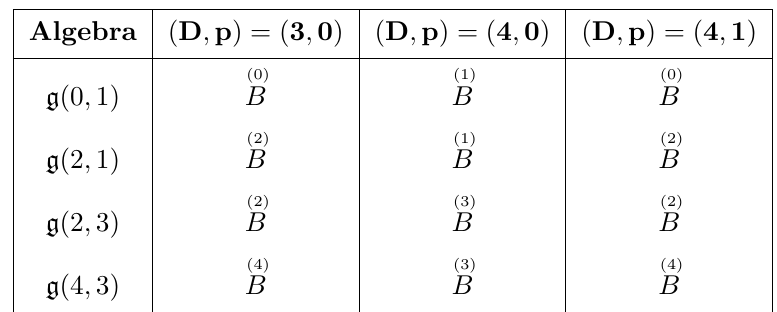
Table 1 . In the table we list, for di(cid:11)erent values of ( D; p ; N is invariant under the algebra g ( N 0 ; N 1 ) appearing in the (cid:12)rst column. The (cid:12)rst line corresponds to Galilei gravity that always occurs as the lowest-order term in the Lie algebra expansion. In this section we are going to discuss the (cid:12)ve cases ( D; p ; N 0 ; N 1 ) = (3 ; 0; 2 ; 1), (4 ; 0; 0 ; 1), (4 ; 0; 2 ;